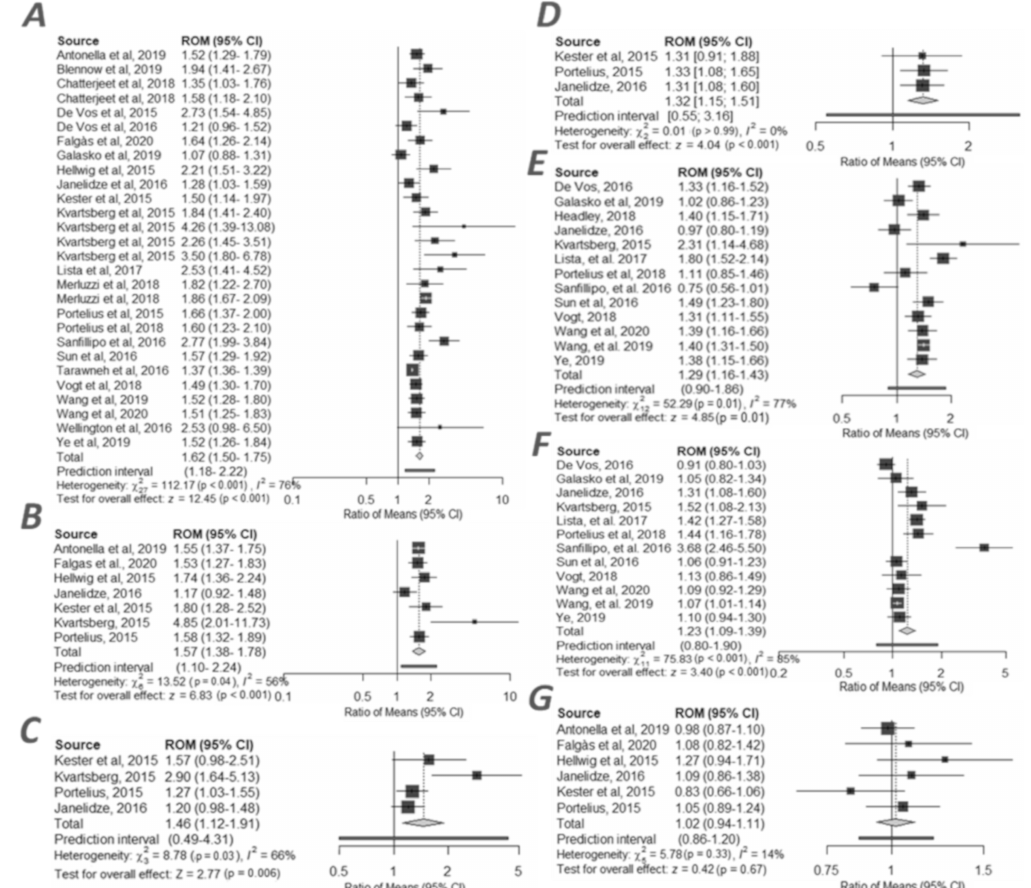
Figure 1. Forest plots of cerebrospinal fluid neurogranin (Ng) ratio in compared groups: ( A ) AD vs. CTRL [5,8–12,14–17,19–21,23,24,26–31,43,49,50]; ( B ) MCI-AD vs. CTRL [5,8–10,14,29,31]; ( C ) MCI-AD vs. sMCI [5,9,10,14]; ( D ) AD vs. sMCI [5,9,14]; ( E ) MCI vs. CTRL [4,9–11,15–17,21,24,28,30,49,50]; ( F ) AD vs. MCI [9–11,15–17,21,24,28,30,49,50]; ( G ) AD vs. MCI-AD [5,8,9,14,29,31]. Individual studies and their corresponding 95% Confidence Intervals (CIs) are indicated by filled squares. All average ratios and their corresponding 95% Cls are indicated by grey